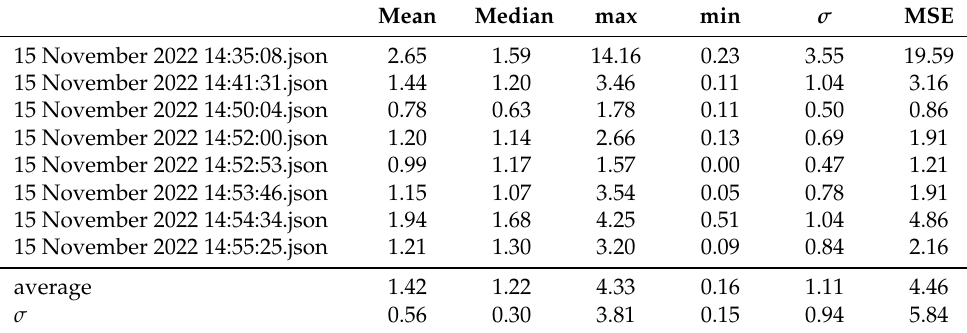
Table 5. Evaluation (Dataset 2): beacon; distance to the ground truth.